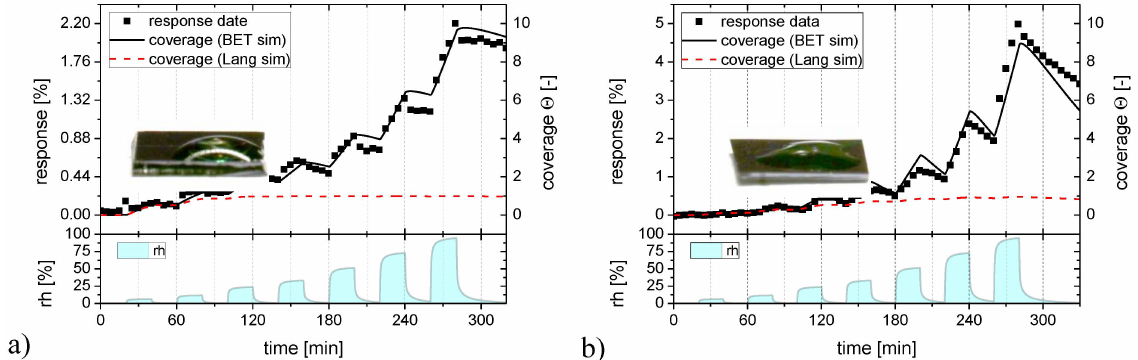
Figure 7. Langmuir (red) and BET (black) adsorption/desorption processes fitted to the humidity response (full squares) of the flat-surface SnO nano-granular morphology ( b